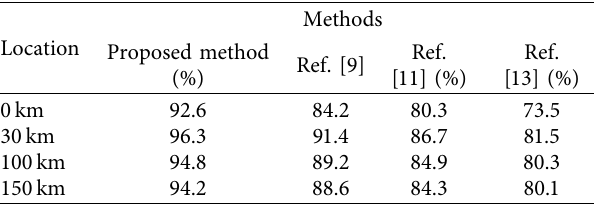
Table 2: Accuracy of different methods when single-pole grounding fault occurs at different locations of lines.